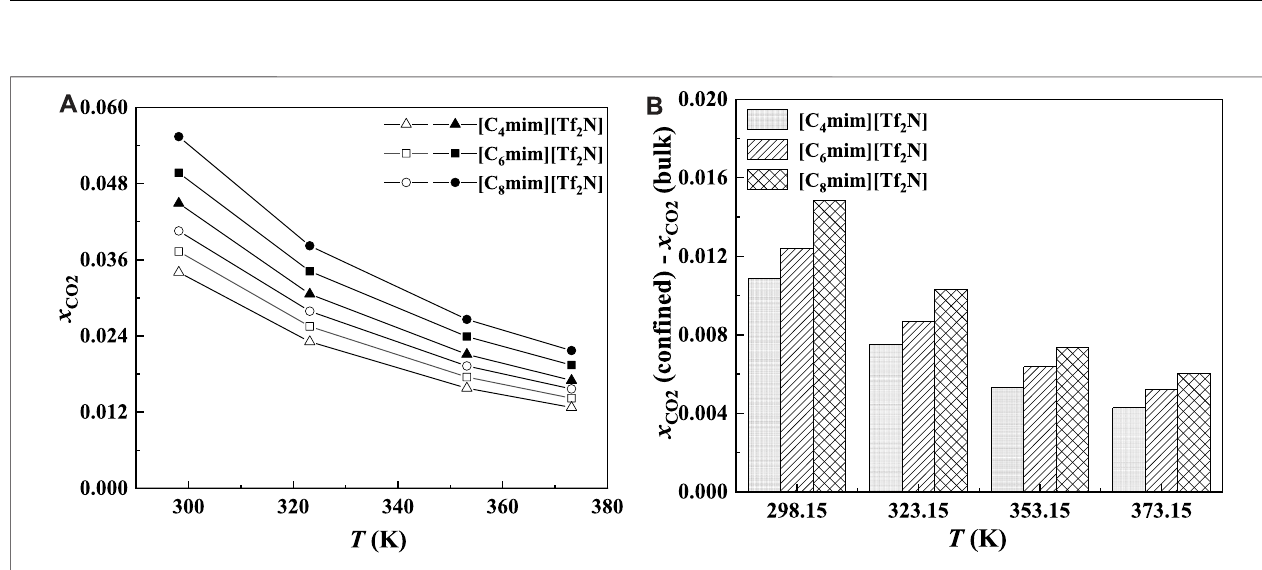
FIGURE 13 | Calculated CO 2 solubility (A) and additional solubilities (B) of ILs con fi ned in 25 Å slit-shaped pore at 1 bar and different temperatures. (A) Solid symbols, data for con fi ned ILs; open symbols, data for bulk ILs.